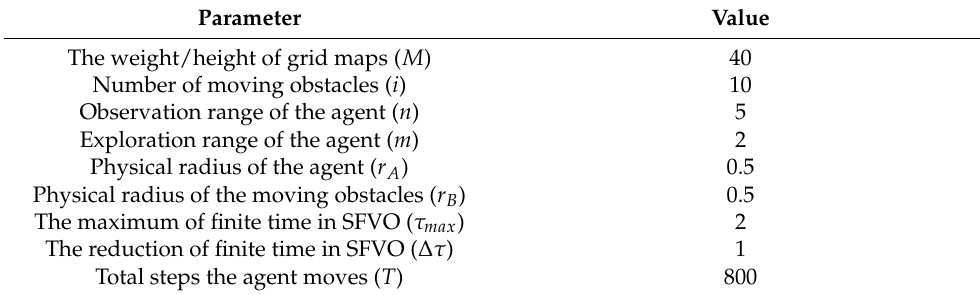
Table 1. Dynamic environment parameter details.